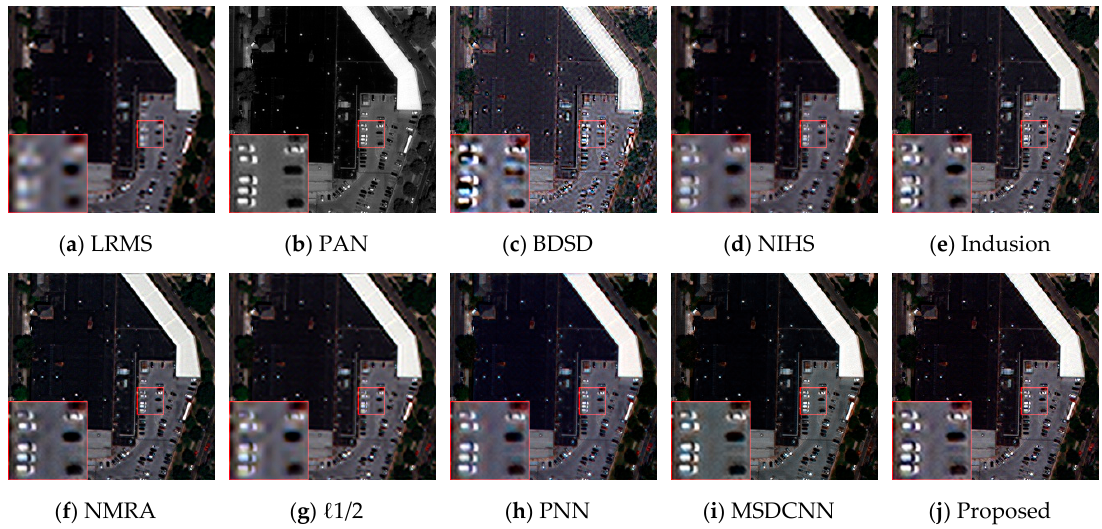
Figure 8. Results of the original scale experiment on an area extracted from a WorldView-2 image. ( a ) LRMS; ( b ) PAN; ( c ) BDSD; ( d ) NIHS; ( e ) Indusion; ( f ) NMRA; ( g ) ℓ 1/2; ( h ) PNN; ( i ) MSDCNN; ( j ) Proposed.